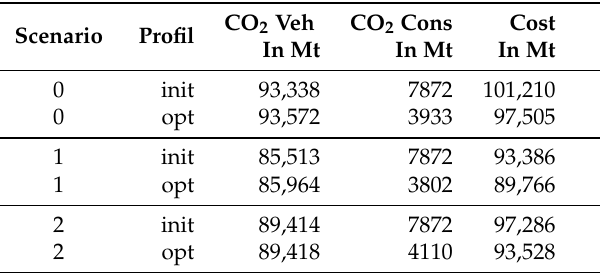
Table 9. Optimal cost for different